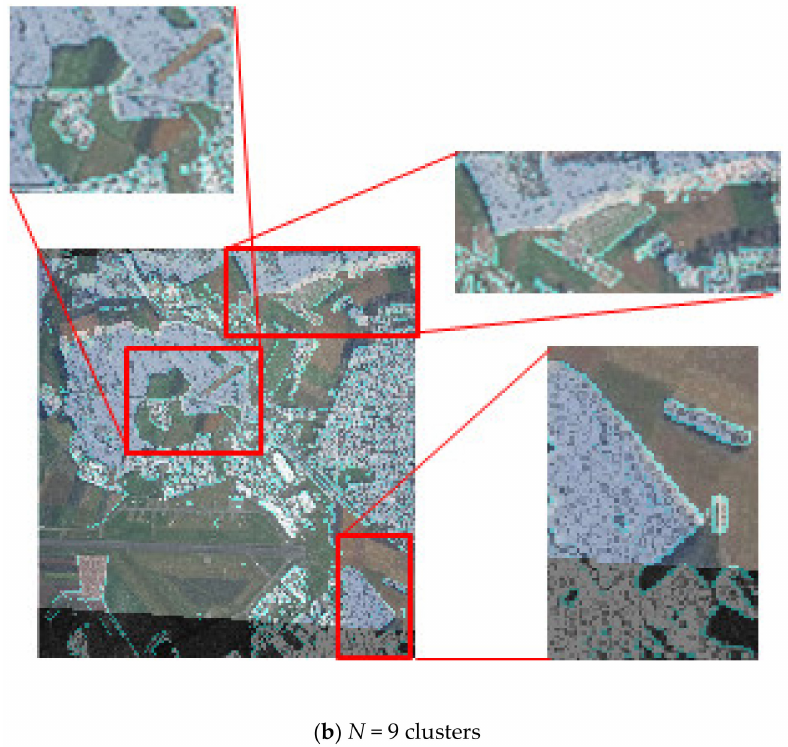
Figure 8. Assessment of the quality of the results of fusion of the original pairs of images with a different number of clusters and, the respective reference points in the